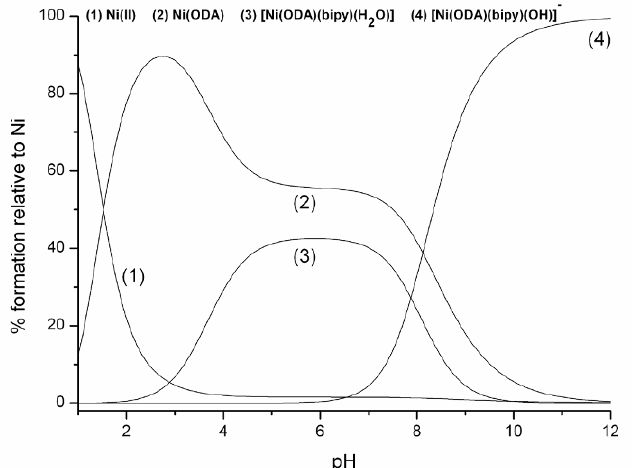
Figure 3. Concentration distributions of Ni(II) (1), Ni-ODA (2), [Ni(ODA)(bipy)(H the Ni(II) – H ODA – bipy 2